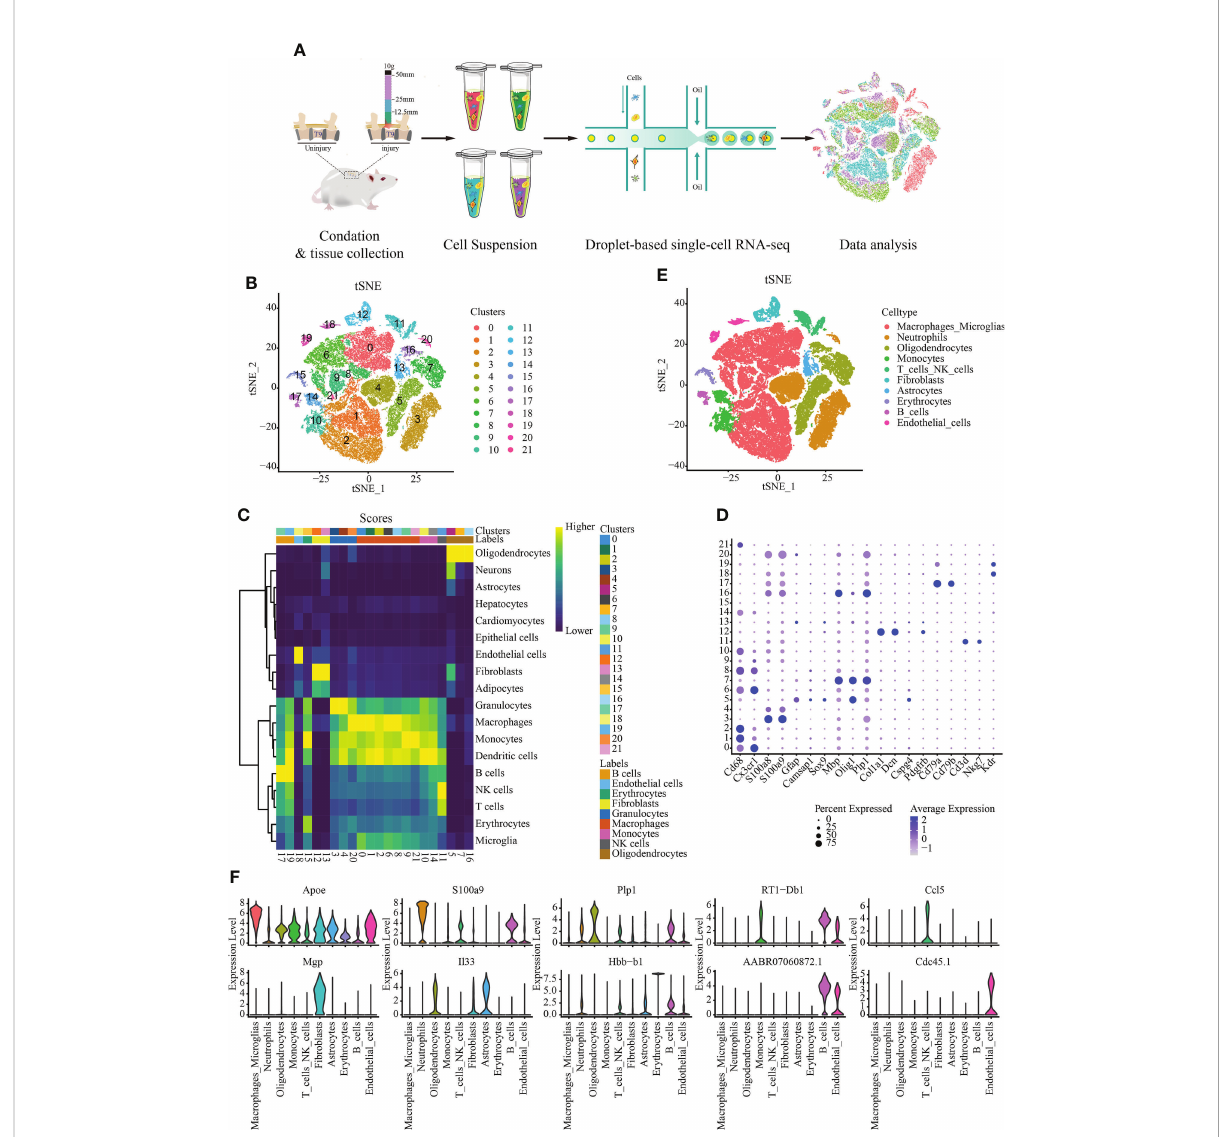
FIGURE 1 Single-cell data set with reduced dimension clustering and cell type identi fi cation. (A) Graphical representation of the experimental work fl ow. (B) Cluster analysis of cell groups was carried out, and t-distributed stochastic neighbor embedding (t-SNE) distribution showing cluster analysis groupings. (C) Heat map showing cell clusters annotated using SingleR. (D) Bubble chart shows the expression of marker genes in each cell cluster. The circle size represents the proportion of gene expression in the cell cluster. Color intensity represents average gene expression. (E) t- SNE distribution of different cell types. (F) Relative marker gene expression among different cell types. The most highly expressed genes in each cell type is displayed. The abscissa represents the cell type, and the ordinate indicates the expression